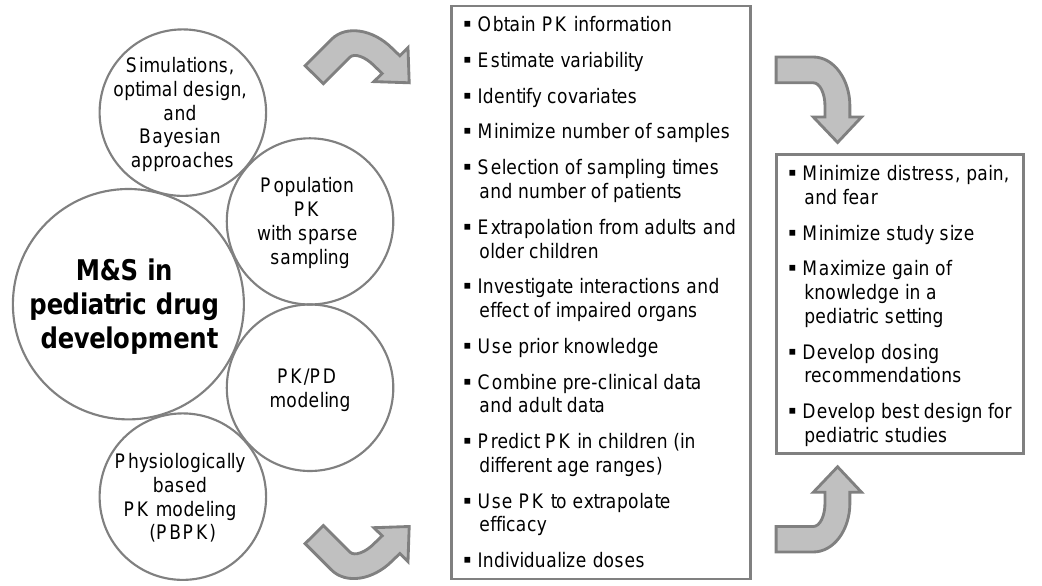
Figure 1. Modeling and Simulation in pediatric drug